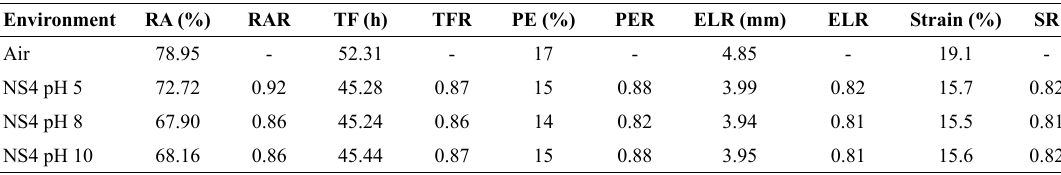
Table 4. SCC index obtained from mechanical properties of